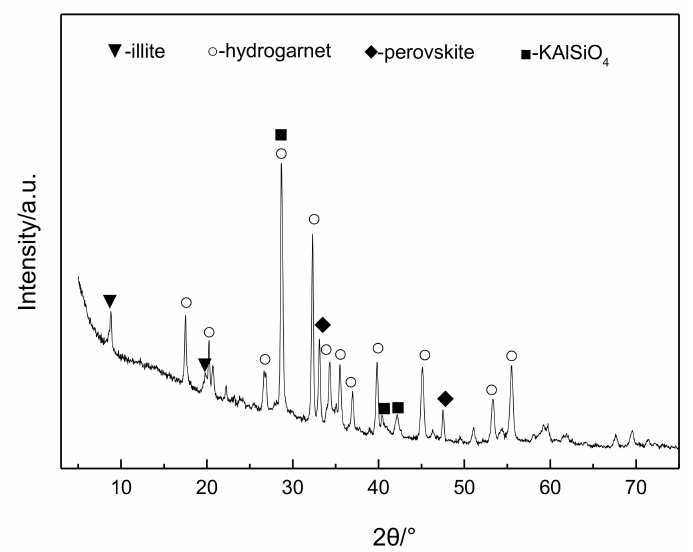
Figure 10. XRD patterns of red mud under the optimum condition( ρ (K 2 O) = 280 g/L, mass ratio of CaO/ore = 16%, T = 260 ◦